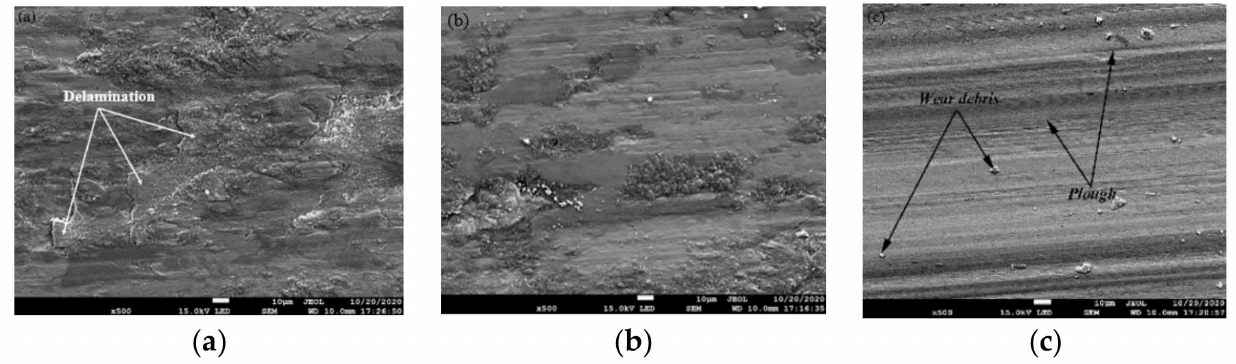
Figure 11. SEM micrographs of the worn surfaces. ( a ) grade 45 steel, ( b ) Ni35 + 20% SiC, ( c ) Ni35 + 20% SiC + 20% Ni/MoS 2